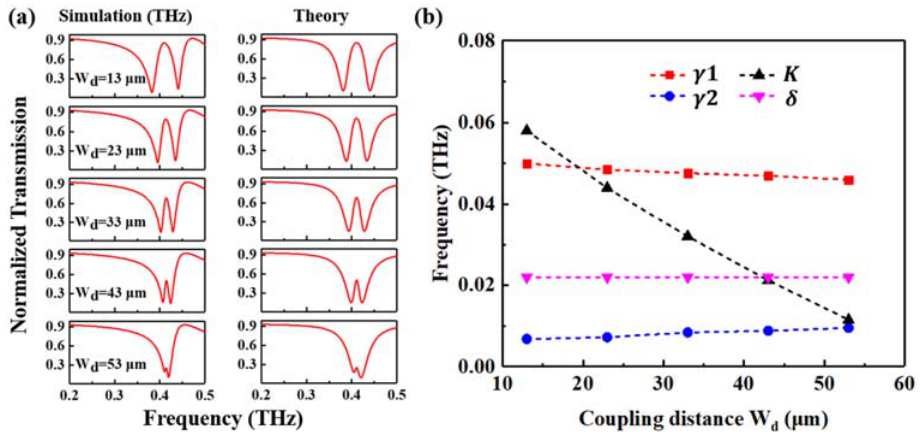
Figure 9. ( a ) Simulation curves and theoretical fitting transmission curves of the proposed EIT MTM with the coupling distance W d from 13 to 53 μ m. ( b ) The fitting parameters used in the theoretical transmission spectra. The unit of 𝜅 is THz 2 .